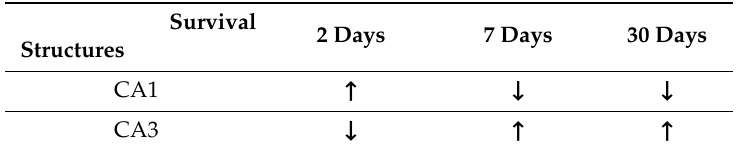
Table 6. Changes in the expression of the Alzheimer’s disease-associated tau protein gene in di ff erent brain structures at di ff erent times after experimental brain ischemia.